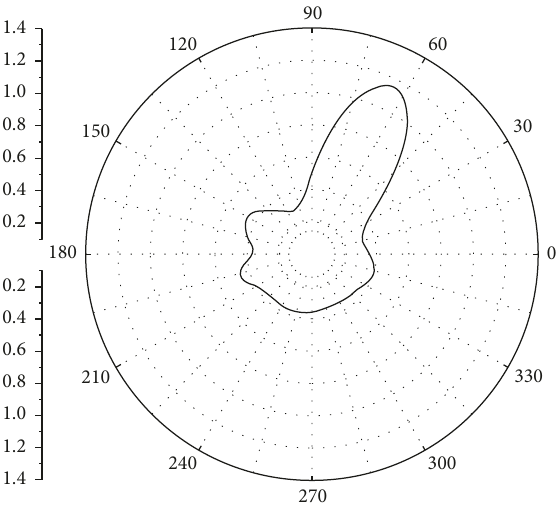
Figure 12: Distribution of peak tensile stress on underlying tunnel induced by full-face